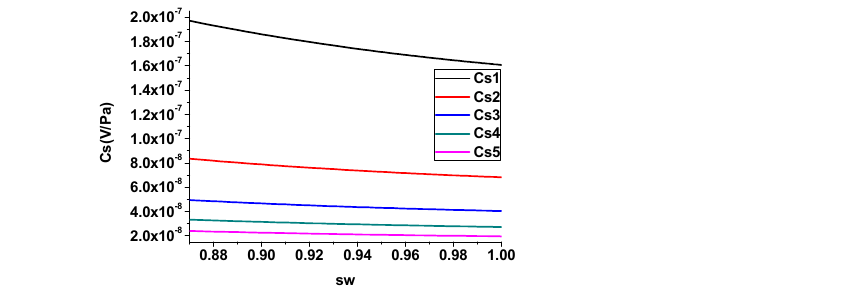
0.001 Pa · s, 0.002Pa · s, 0.003 Pa · s, 0.004 Pa · s, and 0.005 Pa · s, respectively. It can be